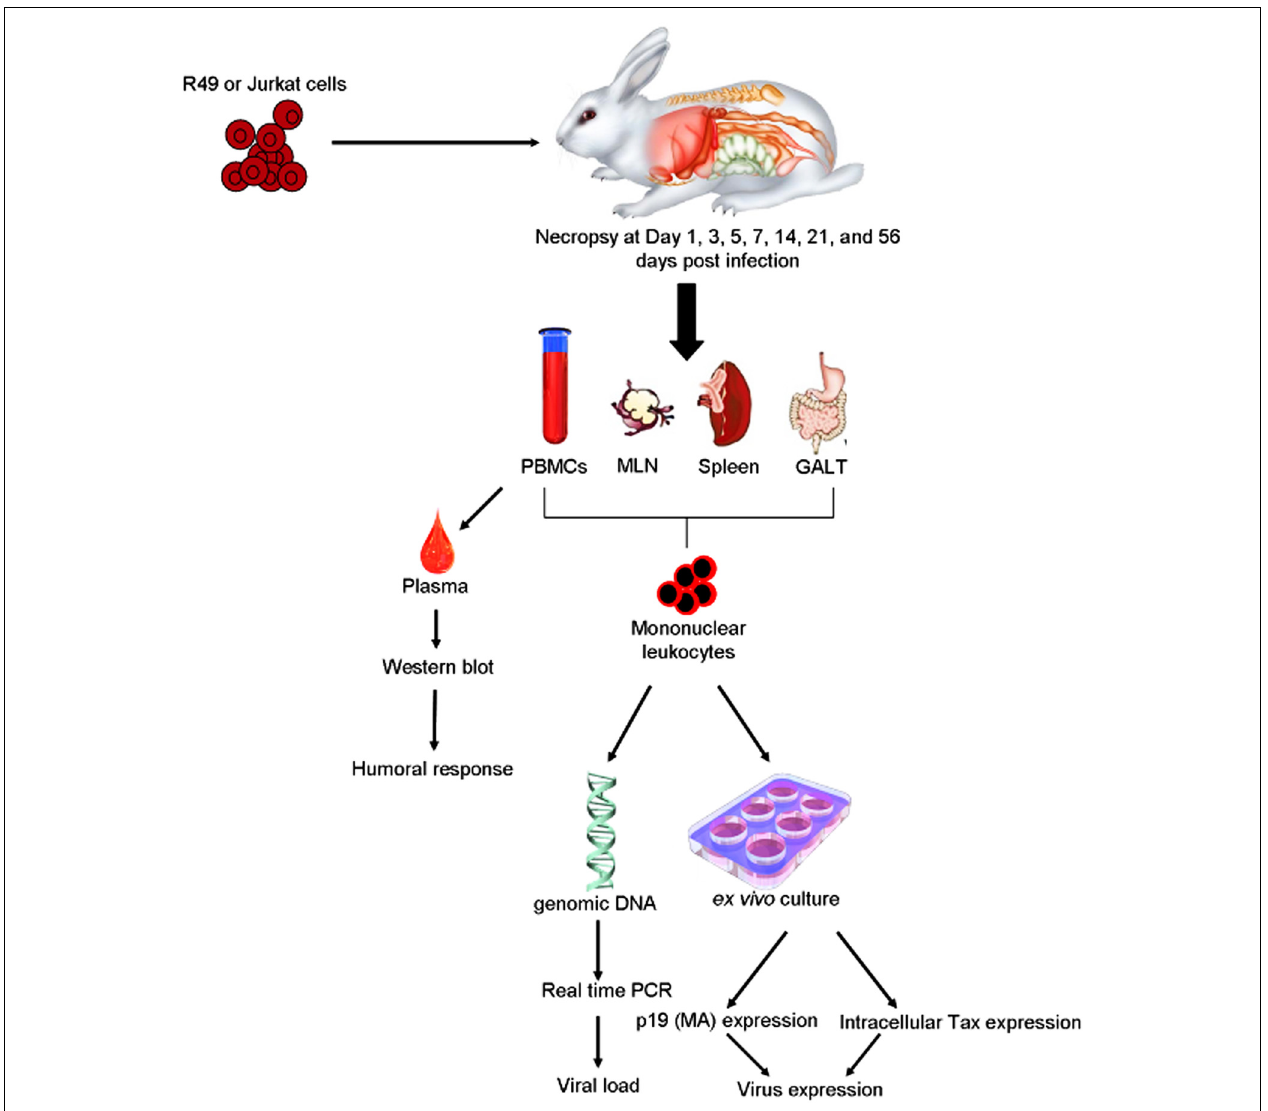
FIGURE 2 | Example of rabbit model of HTLV-1 transmission. Inoculation of HTLV-1 transformed cells, e.g., R49 cells or Jurkat cell controls intravenously or orally to establish infection.Viral parameters measured are